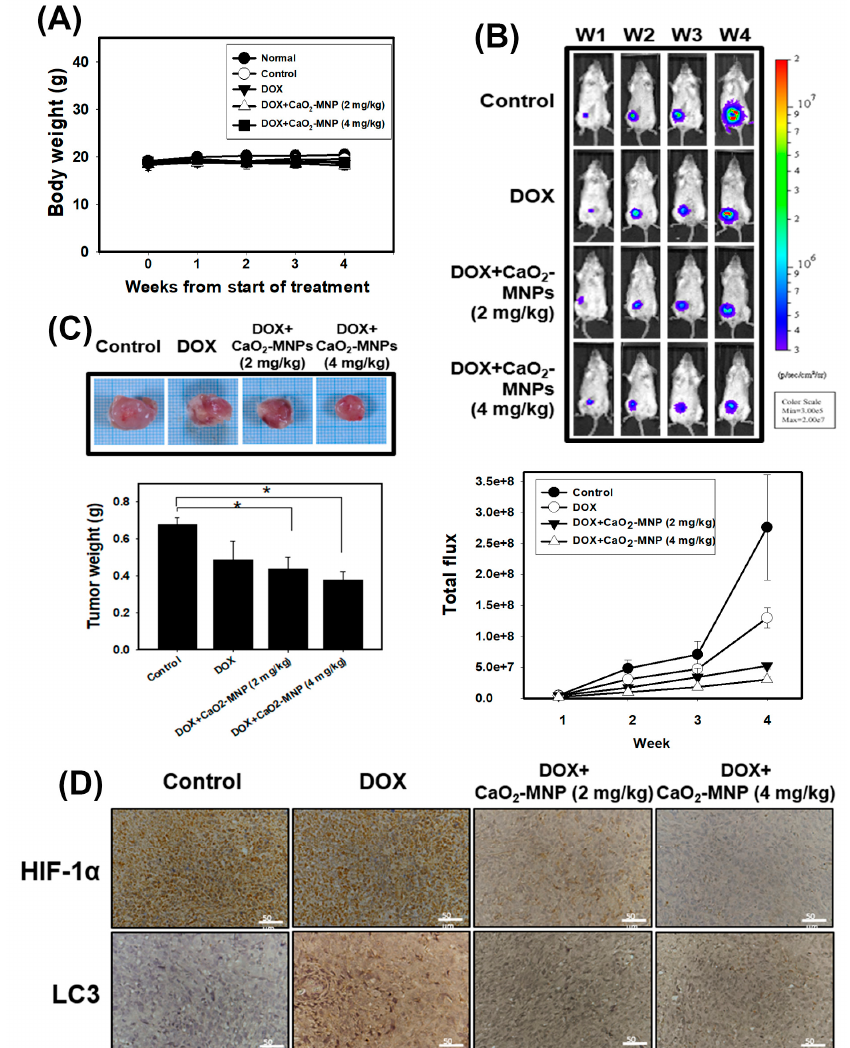
Figure 6. The anti-cancer effects of DOX in combination with CaO 2 -MNPs in an orthotopic mouse model. The female Balb/c mice were injected with 5 × 10 4 4T1 cells orthotopically into the 4th mammary fat pad. ( A ) the body weight was measured weekly in the different groups. ( B ) the bioluminescence imaging of tumors was used in vivo imaging system (IVIS) 200 system with Living Image Software. ( C ) the tumor weight was analyzed after sacrificing. * p < 0.05 control compared with DOX + CaO 2 -MNPs. ( D ) specific immunostaining was conducted on 4T1 tumor sections showing the expression of HIF-1 α and LC3 in response to various treatments in vivo. Scale bars = 50 µ